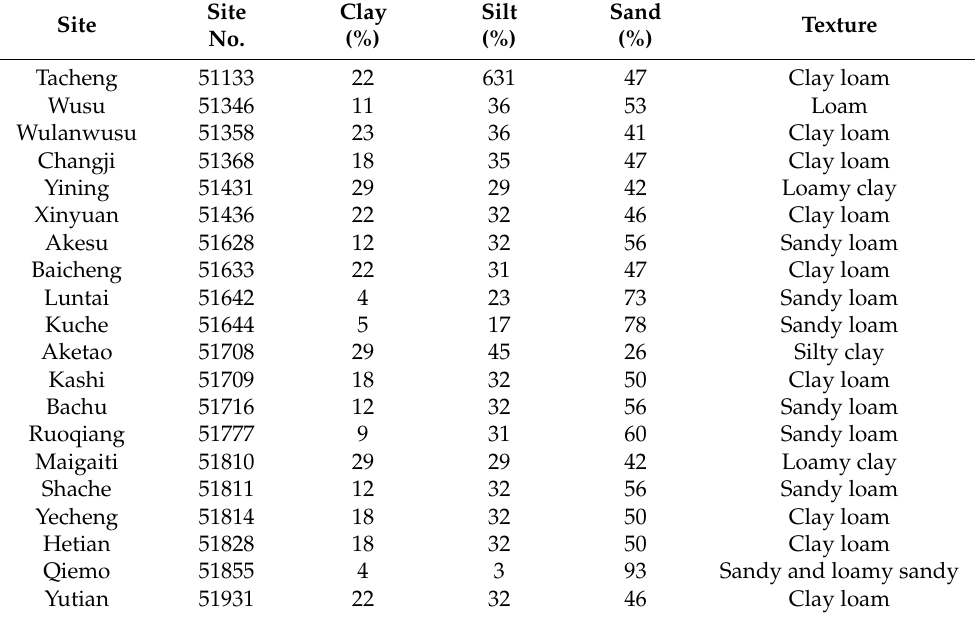
Table A1. The sand, silt and clay content and soil type at the 20 stations in Xinjiang,